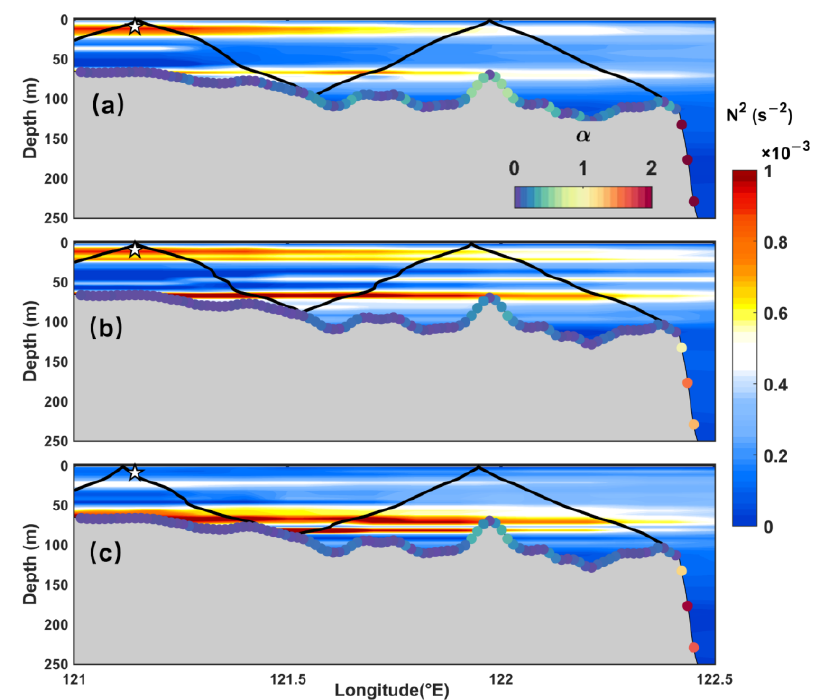
Figure 12. Same as in Figure 11, but for the K 1 tidal beam.